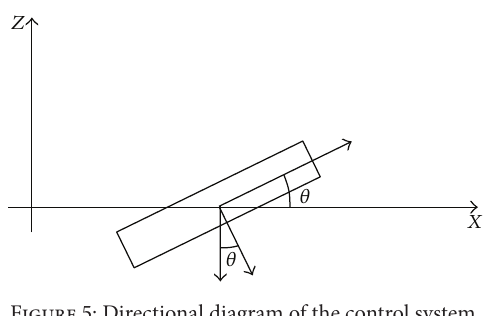
Figure 5: Directional diagram of the control system. Disturbance Error u PID control Plant